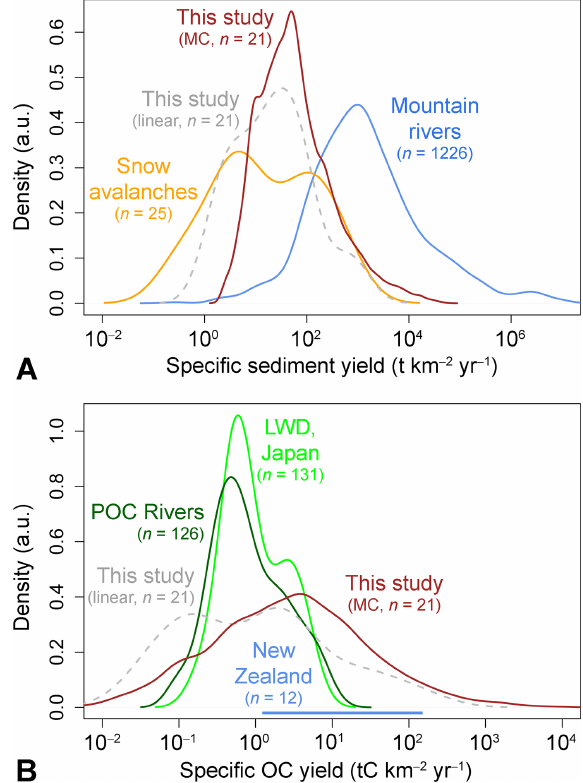
Fig. 6. Comparison of published estimates of specific sediment and particulate organic carbon (POC) yields. (A) Probability density es- timates of multi-year specific sediment yields reported from moun- tain rivers throughout the world (Korup, 2012); attributed to snow avalanches mainly in the European Alps, and the Karakoram; and this study (MC represents a Monte Carlo-based simulation; linear represents the simple product of deposit area and mean debris- cover thickness). (B) Probability density estimates of multi-year POC yields in large rivers worldwide (Beusen et al., 2005); moun- tain rivers in New Zealand (Carey et al., 2005; no reliable density estimate because of low sample size); large woody debris (LWD) fluxes in Japanese mountain rivers (Seo et al., 2008); and this